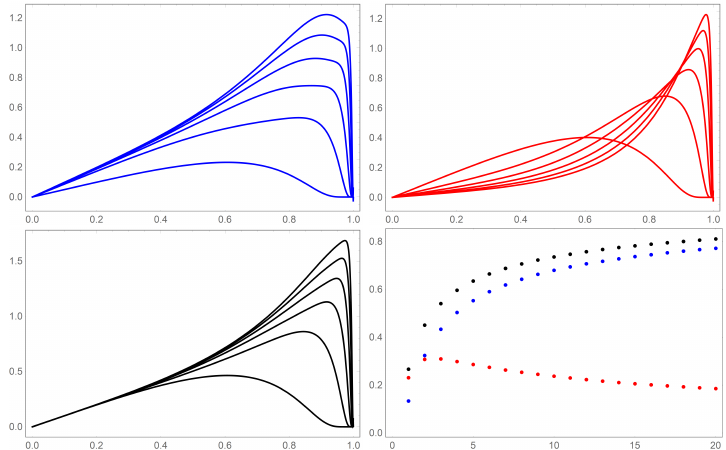
Figure 23. Plots of the real (blue), imaginary (red) and modulus (black) of f 50 ( z ) for the first six symmetry angles and for k = 3. In all cases, the graphs skew toward unity and increase in maximum value as the symmetry angle increases (The top curve in each case corresponds to p = 6 whereas the bottom curve corresponds to p = 1). The bottom right panel shows the value of the integral of the real (blue), imaginary (red) and modulus (black) of f 50 ( z ) as a function of symmetry angle, p